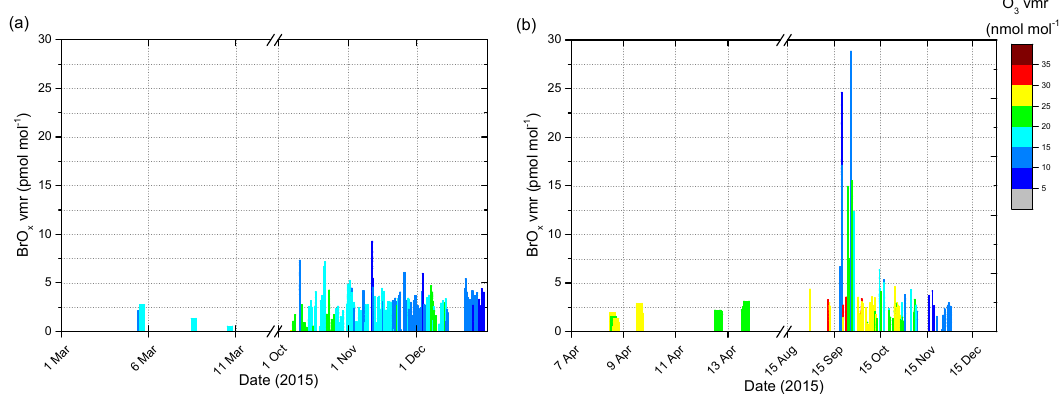
Figure 12. Reactive bromine in the low troposphere of Belgrano (a) and Marambio (b) under different O 3 regimes. The vertical scale depicts the BrO x (Br + BrO) at each station and the color code refers to the collocated observed O 3 vmr. Note that the vertical scale and the color code apply to both figures. Only observations performed under low wind conditions (<6ms − 1 ) and a SZA<75 ◦ are included.